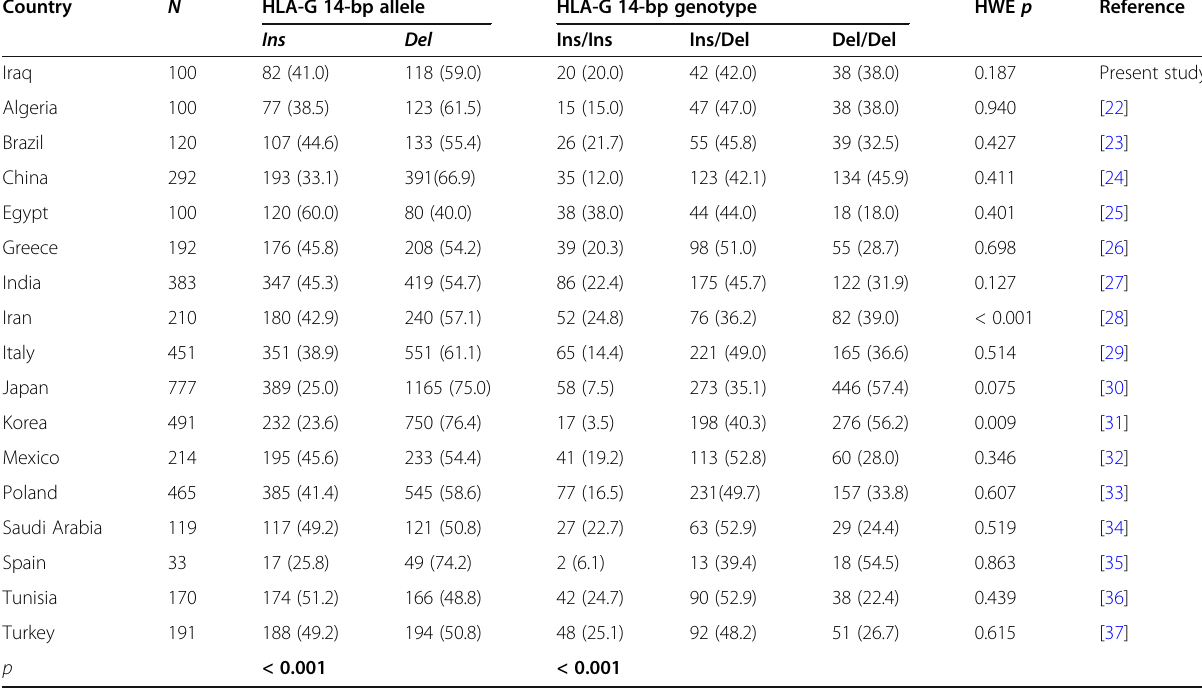
Table 4 Allele and genotype frequencies of HLA-G 14-bp insertion/deletion polymorphism in healthy populations from Iraq and other